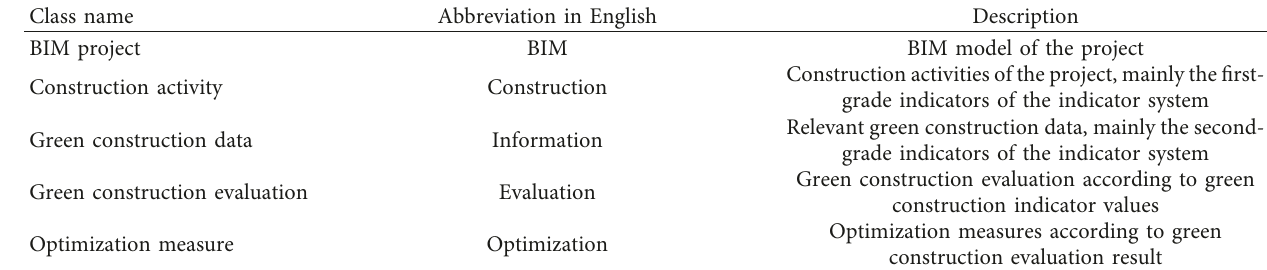
Table 5: Definitions of basic classes.